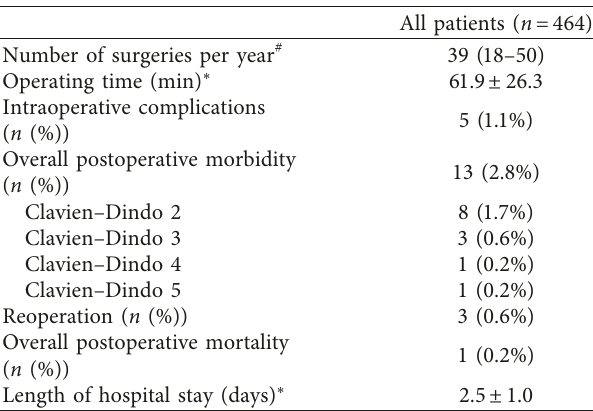
Table 2: Intra- and postoperative